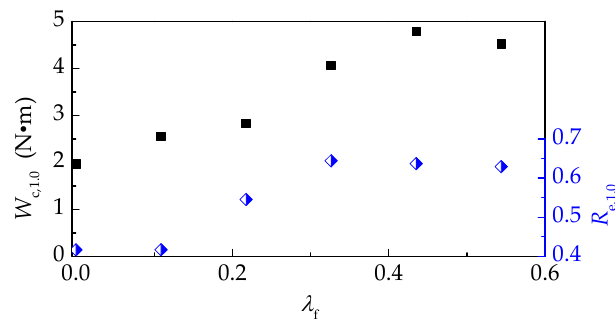
Figure 14. Variation of W c,1.0 and R e,1.0 with a varying λ f.